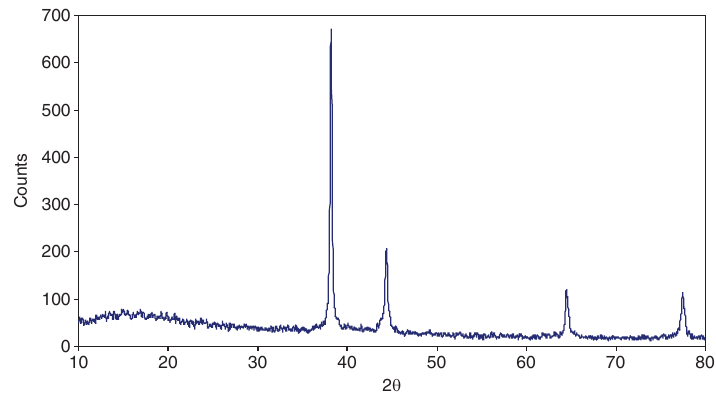
Figure 2 X-ray diffraction (XRD) of silver layers of the nanocomposite